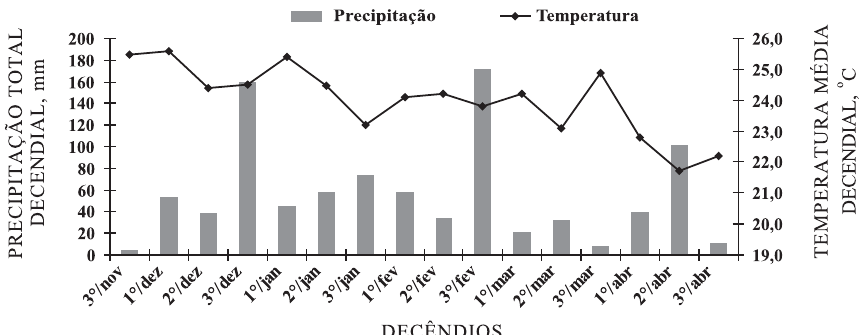
Figura 1. Precipitação pluvial total e temperatura média do ar em cada decêndio na área experimental, no período de novembro de 2007 a abril de